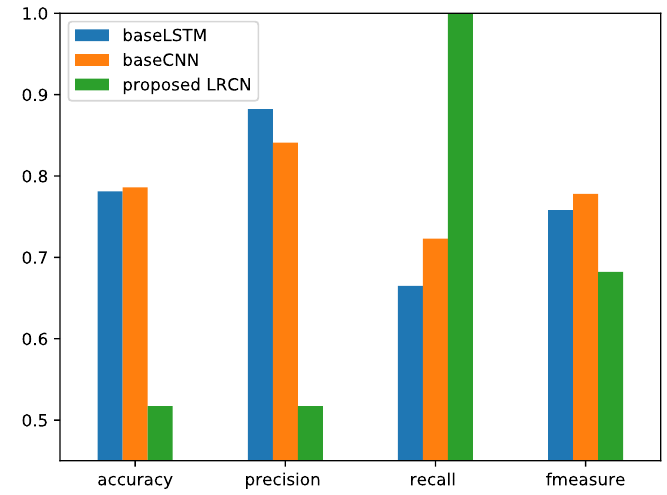
Figure 9. Performance of the spectrum as input for the Jamendo dataset.